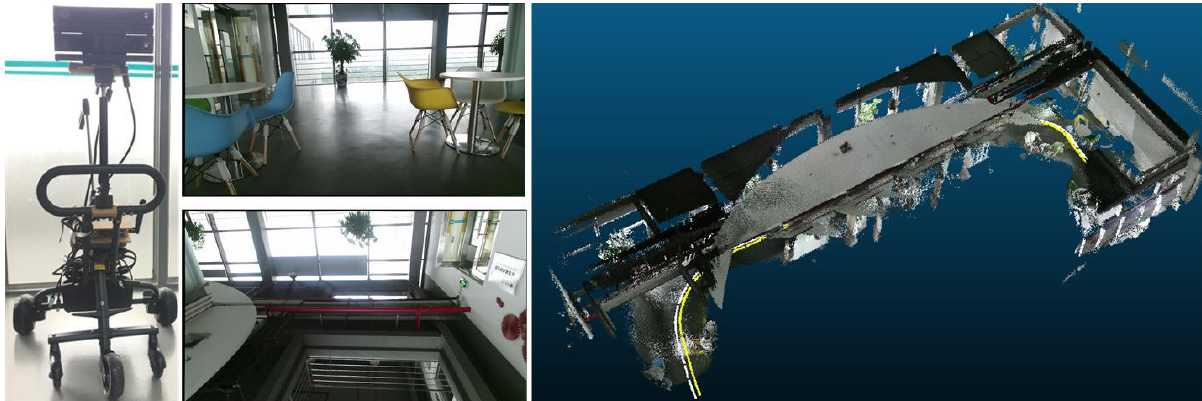
Figure 1. Left: Stereo RGB-D mapping system setup, the two Kinects mounted on a Jetson Tx2, one facing upwards and the other one facing downwards. Middle: Camera views of two camera at the same time-stamp. Right: The built dense point cloud using the two Kinect